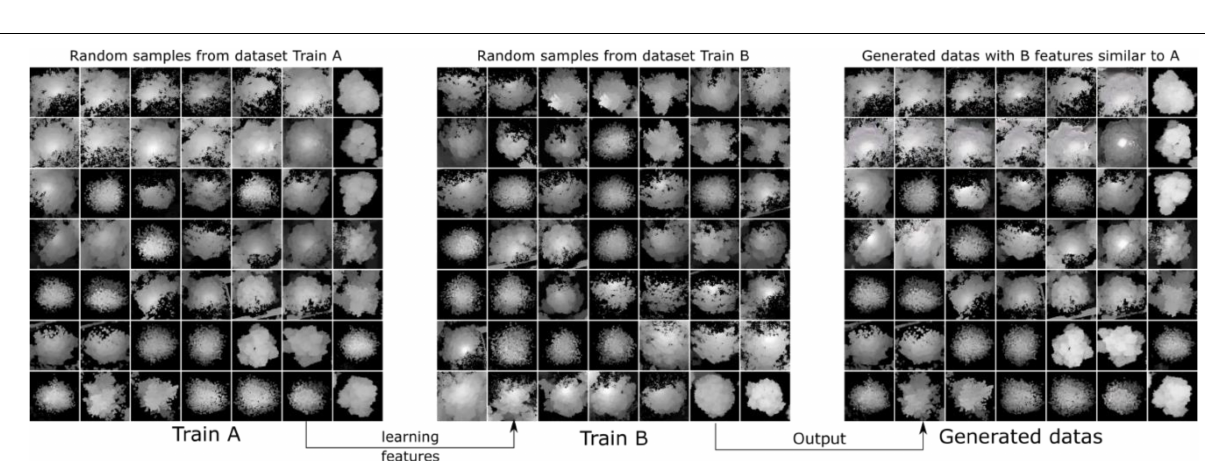
FIGURE 12 | Diagrams showing some of the training samples and generated samples. We collected two sets of training samples in CycleGAN: Train A and Train B. The purpose was to generate style transfer images that are similar to Train A but have the features of Train B.